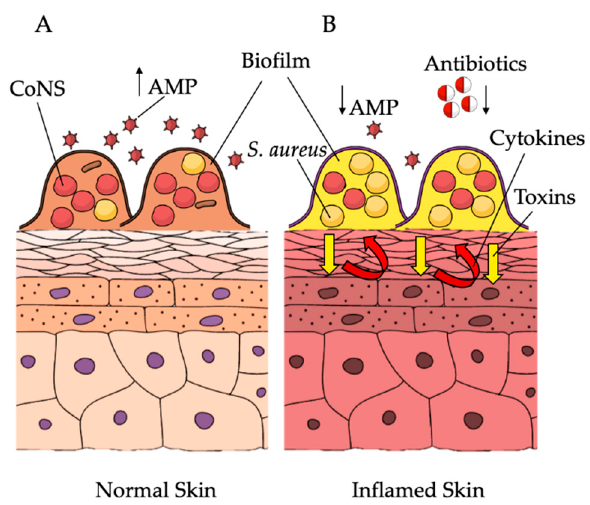
Figure 1. Skin microbiota variation and biofilm production in the pathogenesis of atopic dermatitis. ( A ) In the healthy skin coagulase-negative staphylococci (CoNS) compete with Staphylococcus aureus for the same ecological niche. ( B ) In AD, overexpression of inflammatory cytokines promotes S. aureus overgrowth, thus establishing S. aureus biofilm as the most abundant microorganism at the expense of other skin commensals. In turn, S. aureus participates in sustaining chronic inflammation in eczematous dermatitis. Arrows indicate increase ( ↑ ) and decrease ( ↓ ). The image is adapted from Mind the Graph (https://mindthegraph.com) under a Creative Commons License.